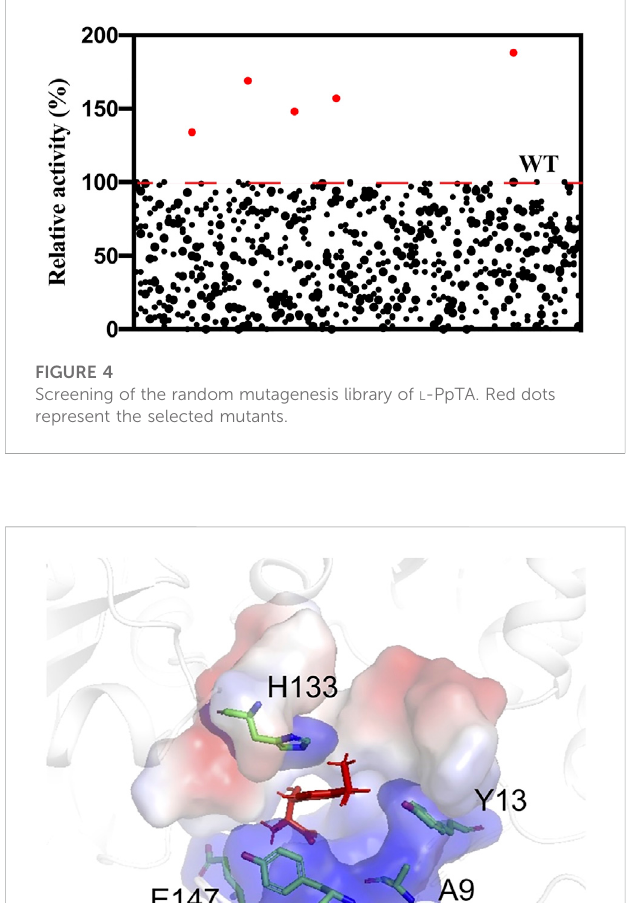
Frontiers in Bioengineering and